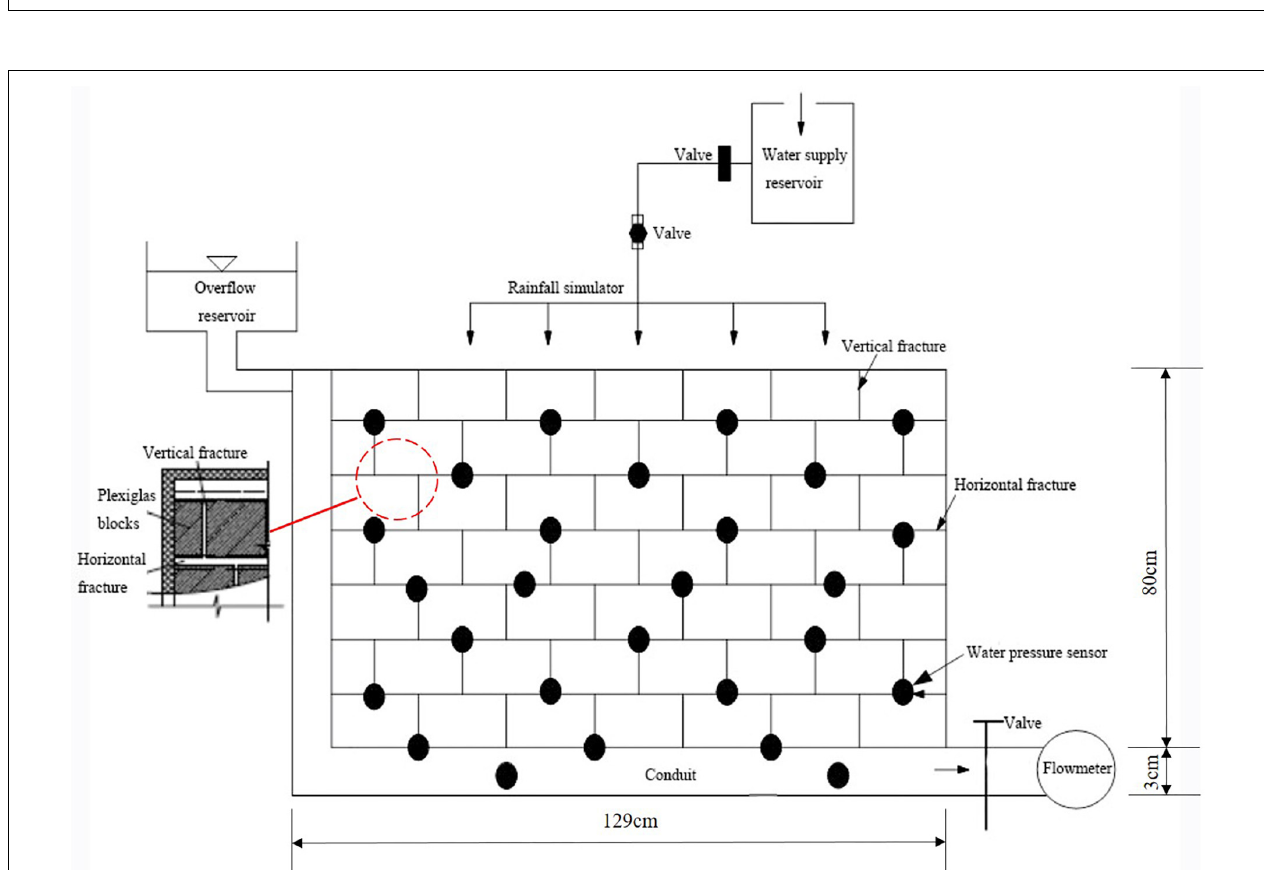
FIGURE 2 | Schematic diagram of the laboratory analog